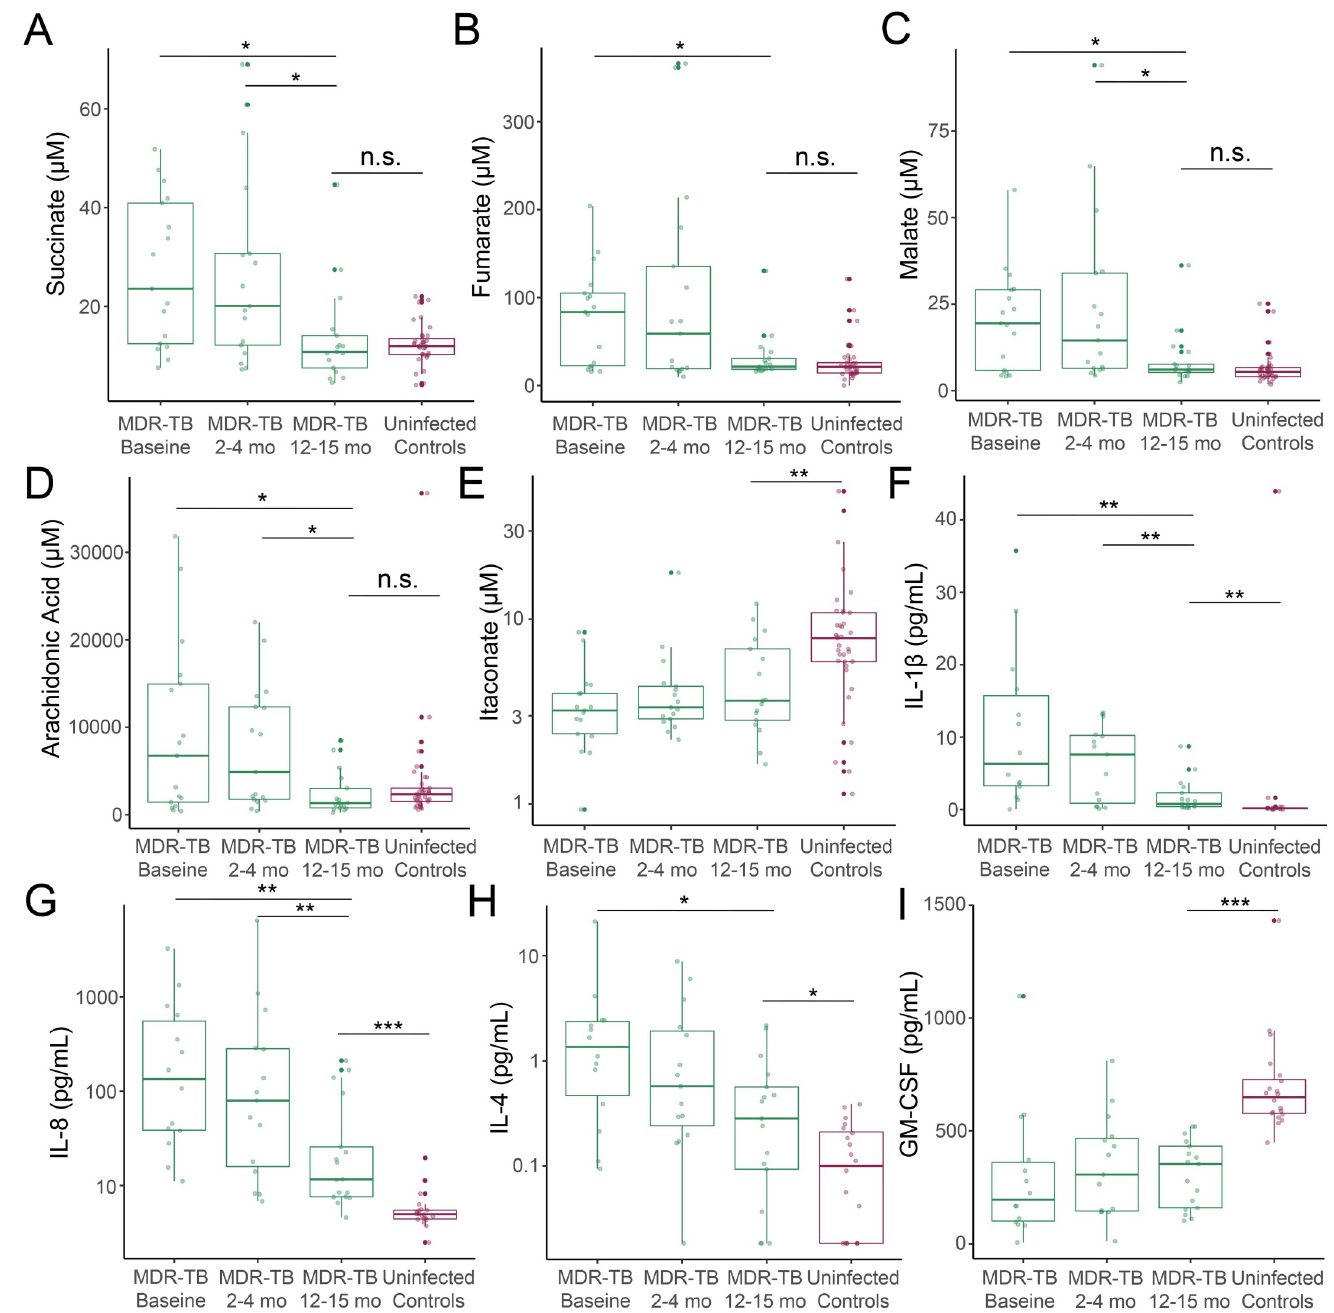
Fig 6. Proinflammatory immunometabolic changes are reversed with appropriate TB treatment. In persons with multidrug resistant (MDR)-TB (n = 17) here was a significant decline in plasma concentrations of (A) succinate, (B) fumarate, (C) malate, and (D) arachidonic acid after 1 year of TB therapy with concentrations declining to similar levels as controls without Mtb infection. (E) While plasma itaconate concentrations increased after 2–4 months and 1 year of treatment, this did not meet statistical significance and remained significantly lower than controls. Plasma concentrations of (F) IL-1 β , (G) IL-8, and (H) IL-4 also significantly declined after 1 year of treatment, but remained significantly higher than uninfected controls. (I) Plasma concentrations of GM-CSF did not significantly change with MDR-TB treatment and remained significantly lower than those of controls. Groups were compared using the Wilcox signed rank test: � p < 0.05, �� p < 0.01, ��� p <